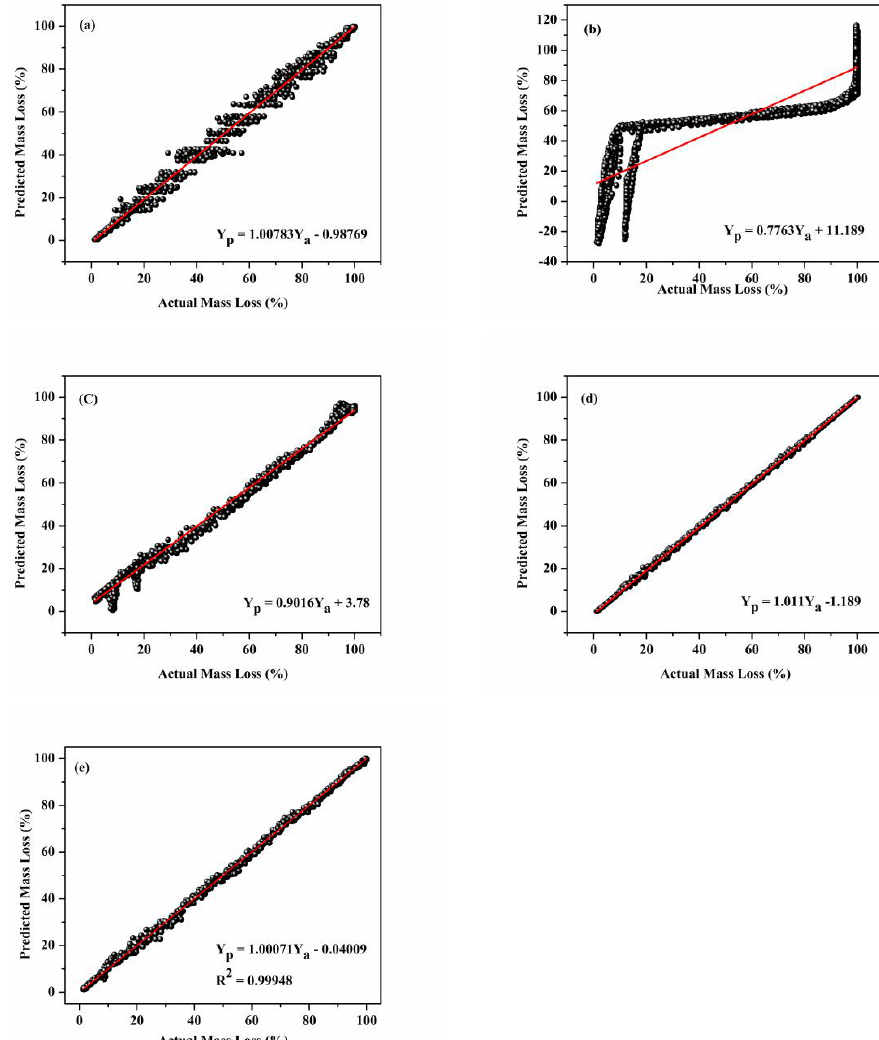
Figure 11. Regression plots of trained data for developed machine learning models ( a ) Random Forest ( b ) Linear regression ( c ) SVM ( d ) Gaussian process regression ( e ) ANN.